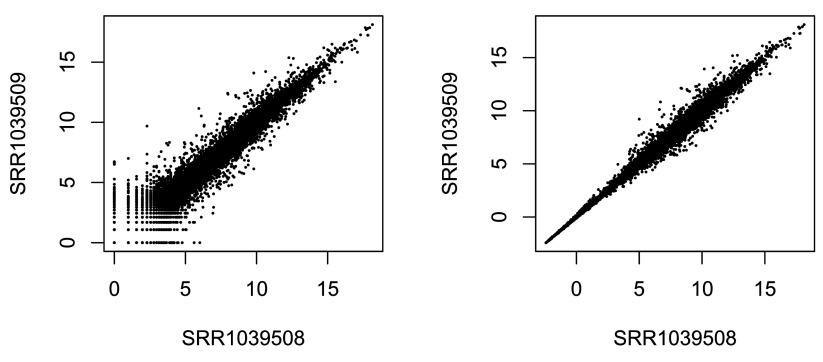
Scatterplot of transformed counts from two samples.Shown are scatterplots using the log2 transform of normalized counts (left side) and using the rlog (right side).